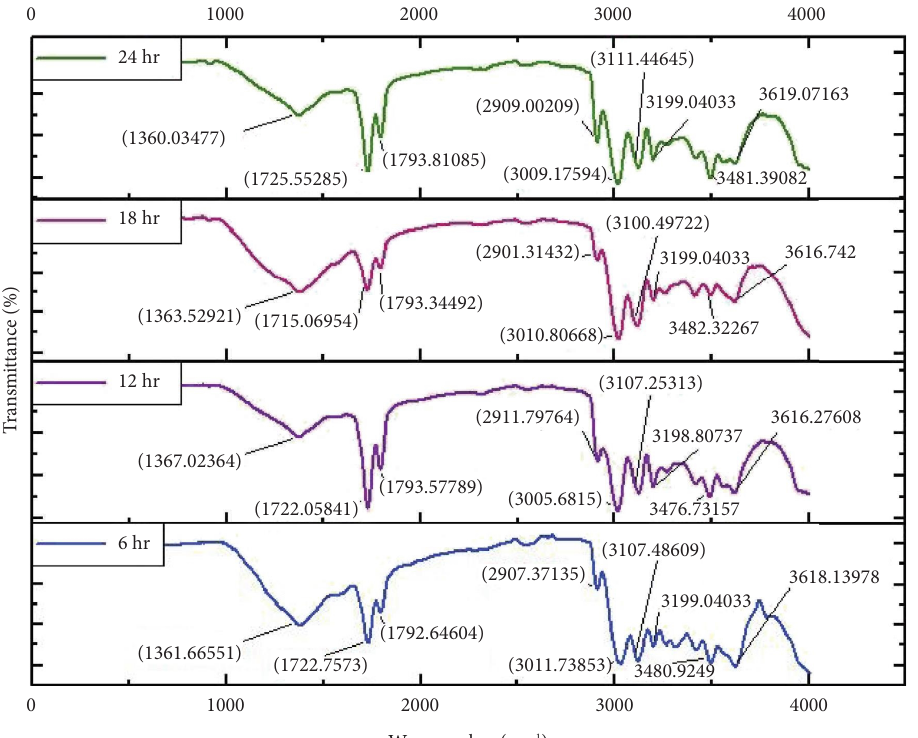
Figure 3: FTIR spectra of